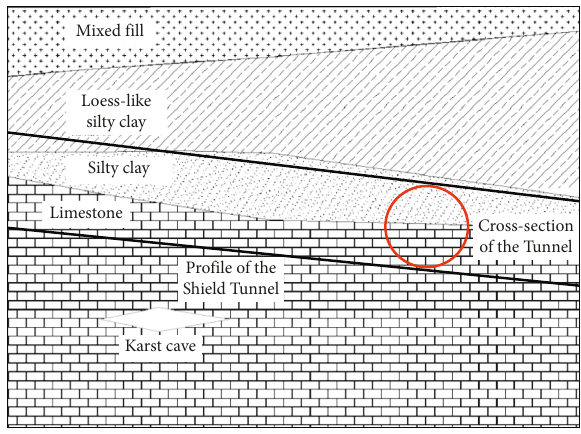
Figure 1: Schematic diagram of rail transit no. 4